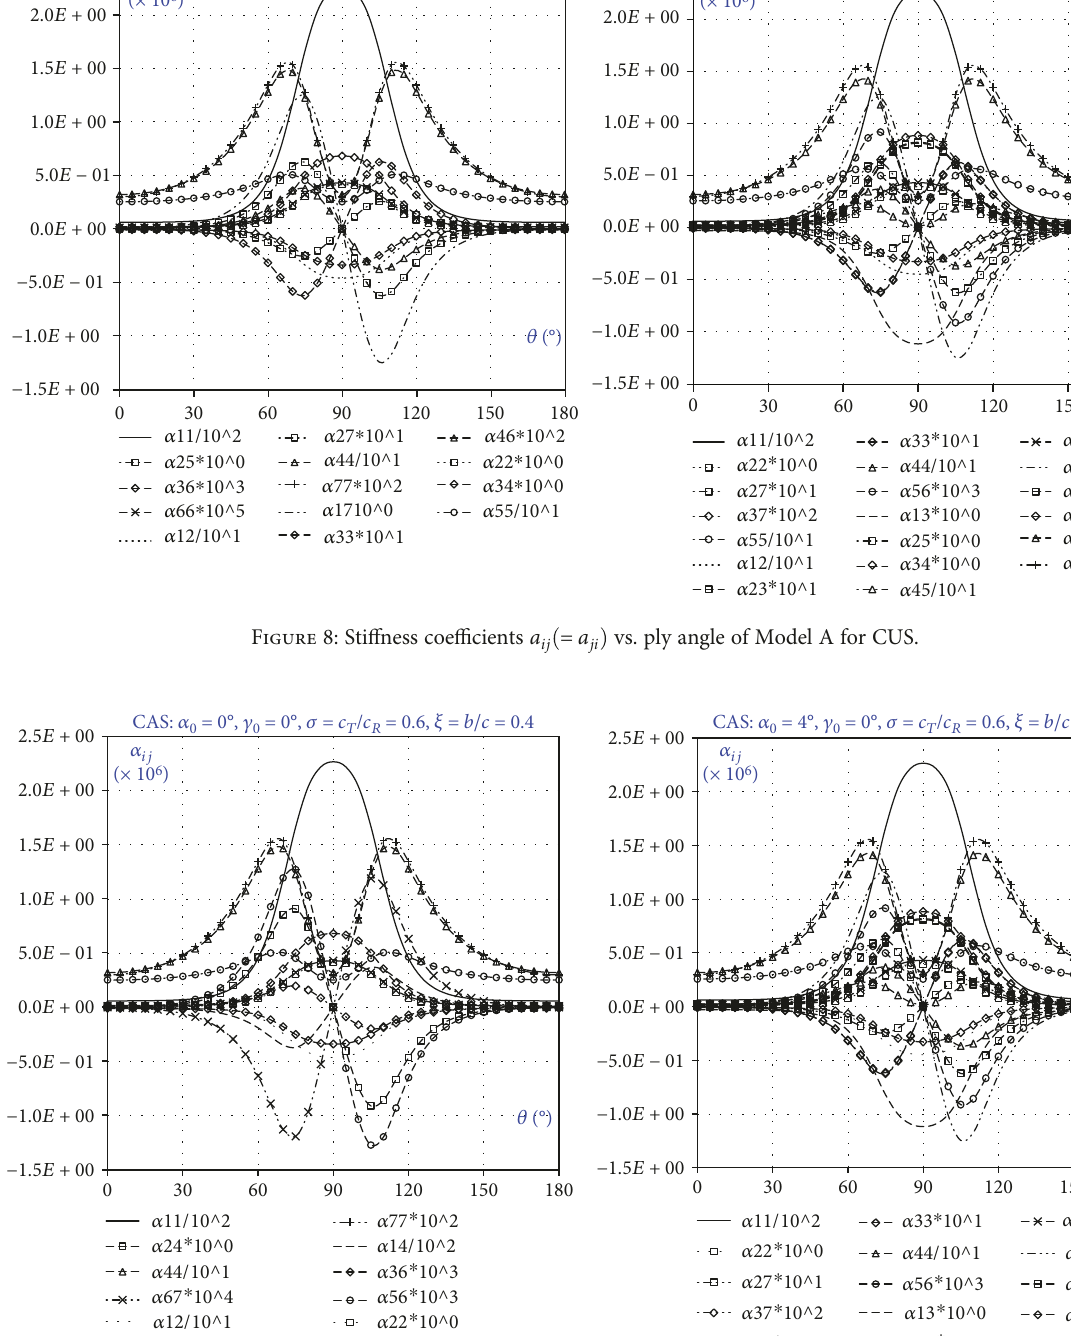
Figure 9: Sti ff ness coe ffi cients a